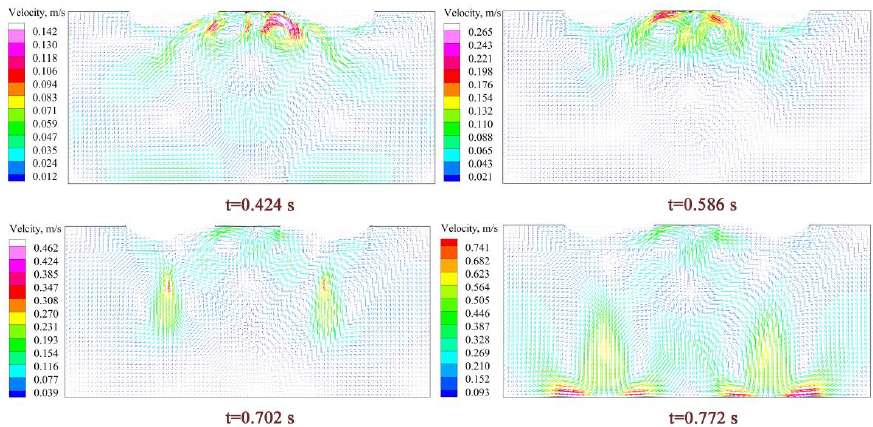
Figure 15. Distribution of velocity field during droplet dripping process of TSCE-ESR.